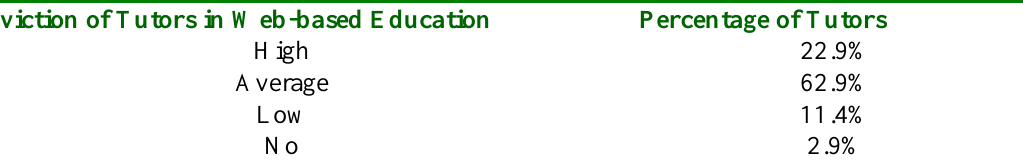
Table 14. Tutor conviction in the capability of Web-based education in developing qualified English